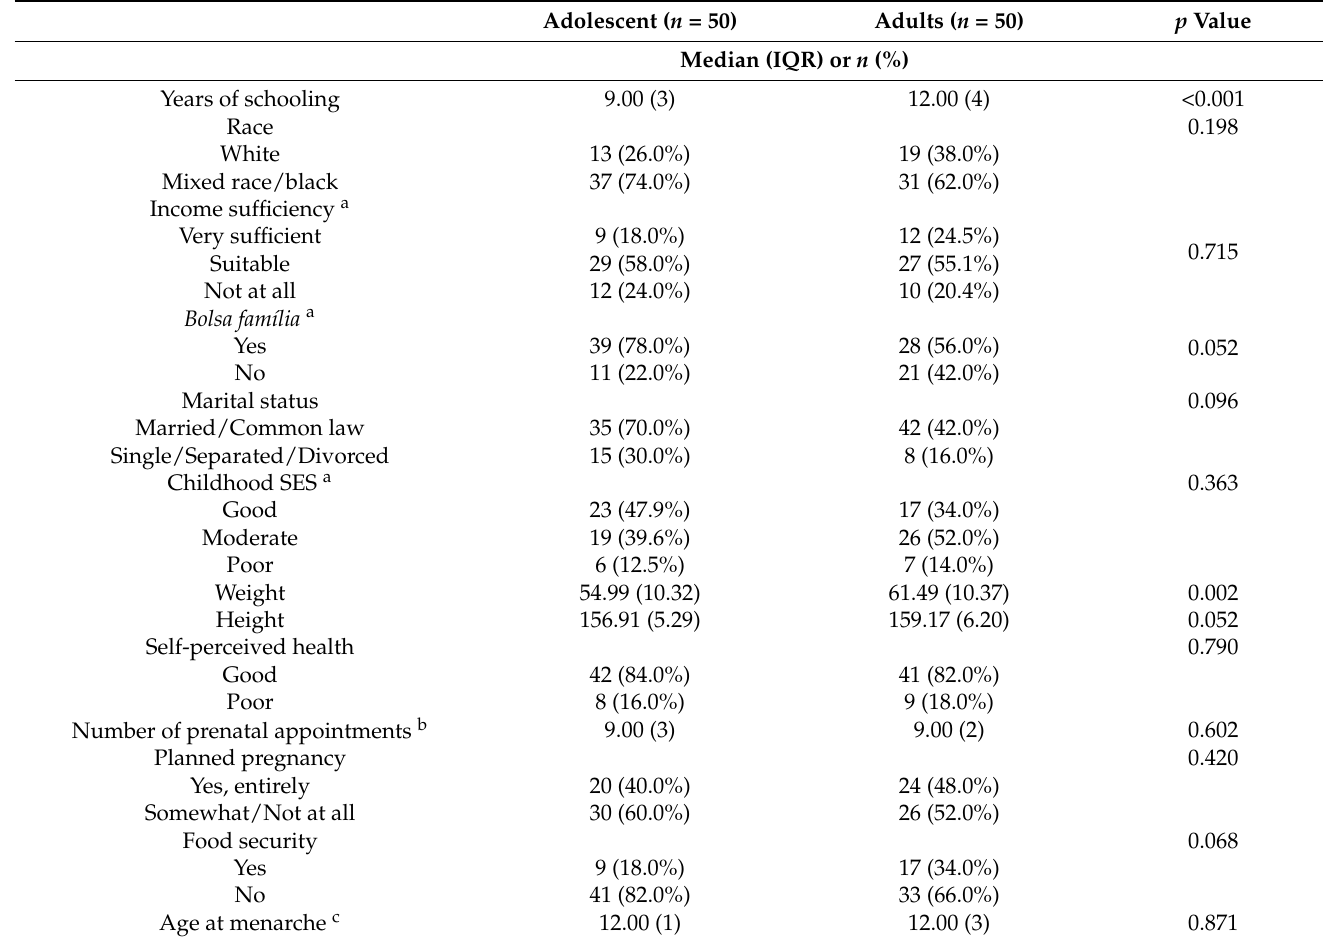
Table 1. Baseline sample characteristics (N = 100). Trairi region, Rio Grande do Norte, Brazil, 2017–2019.